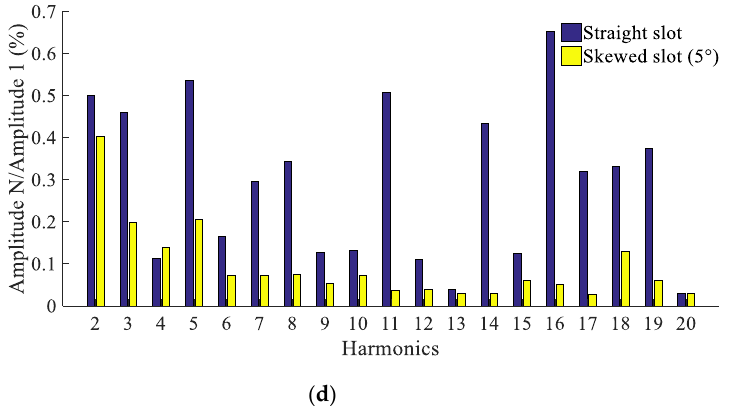
Figure 6. Simulation model and back EMF waveform comparison. ( a ) Mesh dividing; ( b ) Simulation model; ( c ) Comparison of back EMF waveforms (1000 r/min); ( d ) Harmonics comparison of back EMF waveforms.